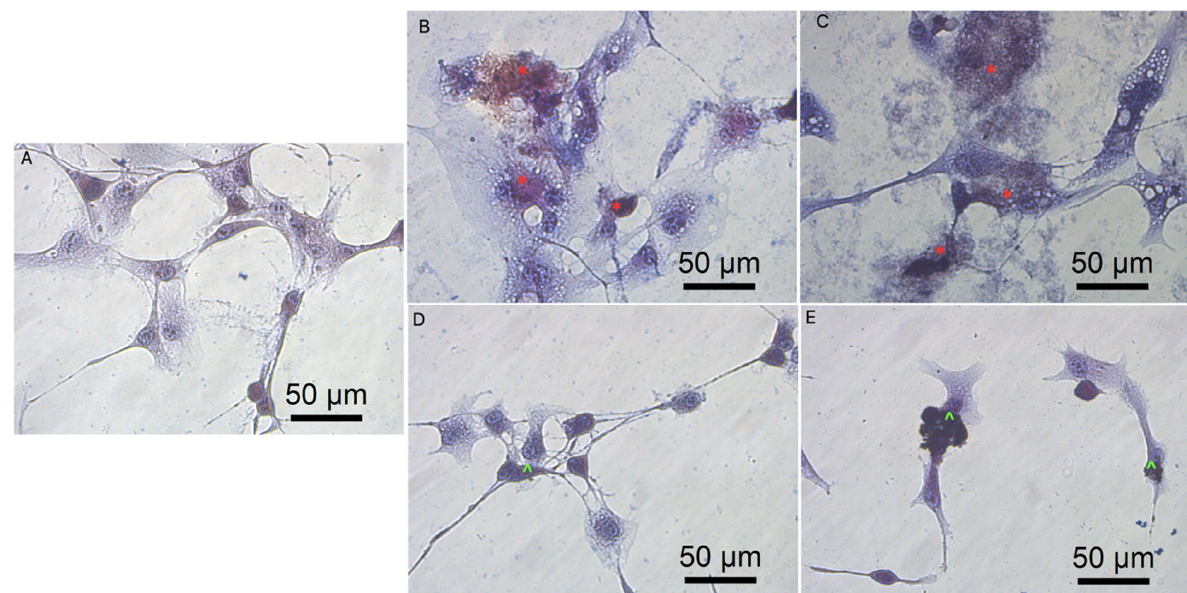
Figure 5. Morphology of U87 glioblastoma cells. ( A ) untreated cells (control group), cells treated with graphene oxide at concentration: 5 µ g/mL ( B ), 100 µ g/mL ( C ), and reduced graphene oxide at concentration: 5 µ g/mL ( D ) and 100 µ g/mL ( E ). Red * GO at cell membrane. Green ˆ rGO at cell membrane. Light optical microscopy. Scale bars: 50 µ m. ( A – E ). Abbreviations: GO: graphene oxide, rGO: reduced graphene oxide.